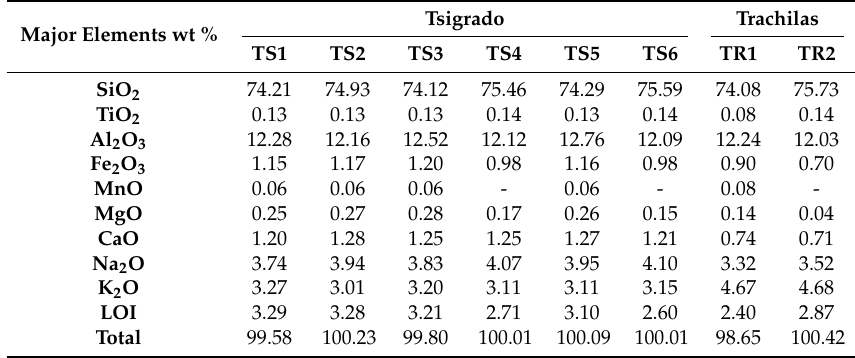
Table 2. Whole-rock chemical composition of crude 1.18–2.5 mm perlite samples from Tsigrado and Trachilas areas (-: below detection limit; LOI: loss on